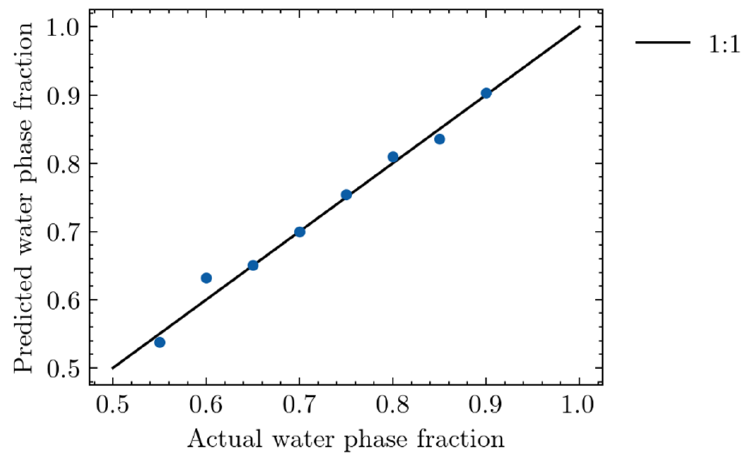
Figure 5. Actual against predicted water phase fraction for kerosene in water emulsion measured by conductivity.